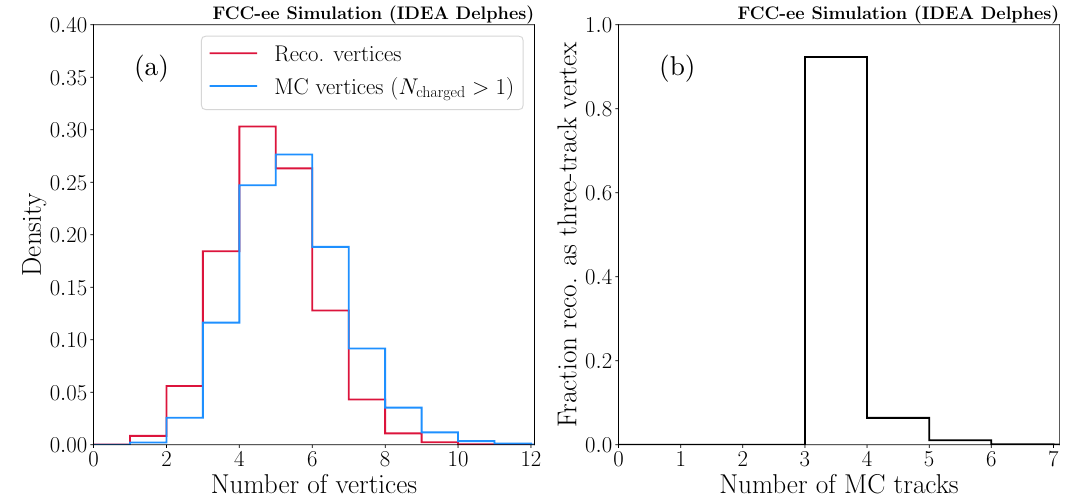
Figure 1 . (a) Comparison of normalised number of truth-level MC vertices (red) and number of reconstructed vertices (blue), where MC vertices with one or more charged particle are shown. (b) Proportion of three-track reconstructed vertices that correspond to MC vertices with different numbers of charged particles. Over 90% of reconstructed three-track vertices originate from a true three-track MC